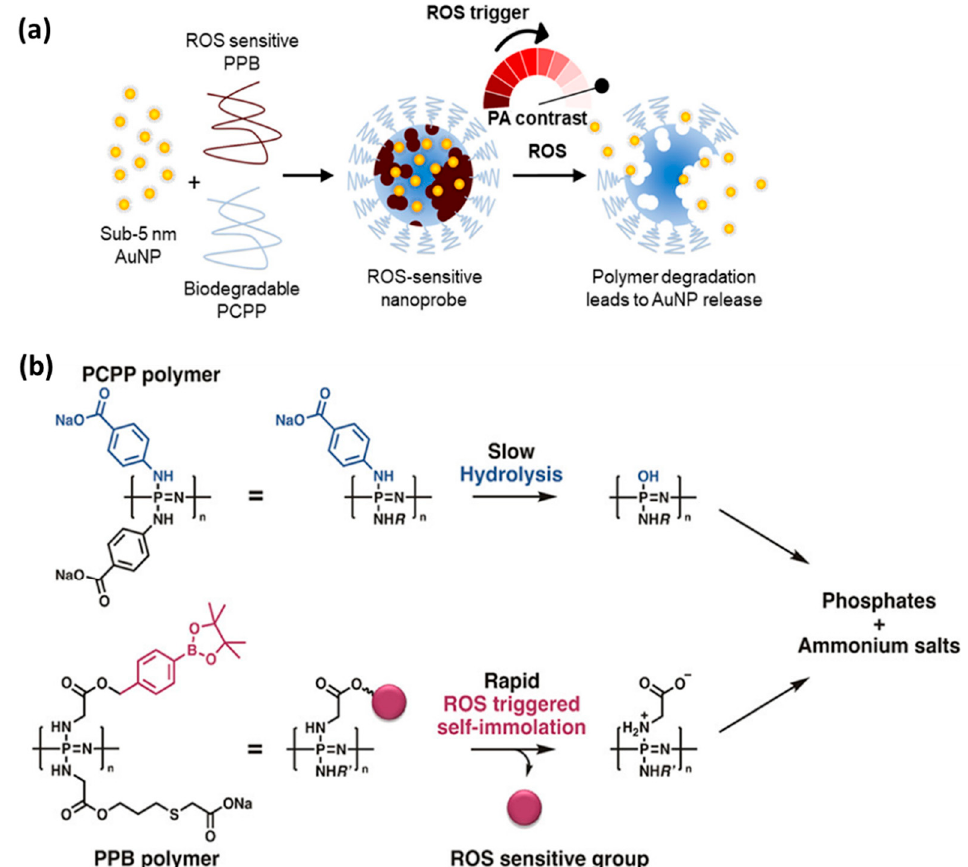
Figure 5. ( a ) Assembly of AuNP in nanogels that selectively degrade under ROS exposure and release free AuNP for imaging of ROS with PA; ( b ) Degradation pathways of PCPP (Upper) and the ROS ‐ sensitive PPB (lower) yielding neutral pH and nontoxic byproducts. Adapted and reused from [50], American Chemical Society, 2019.